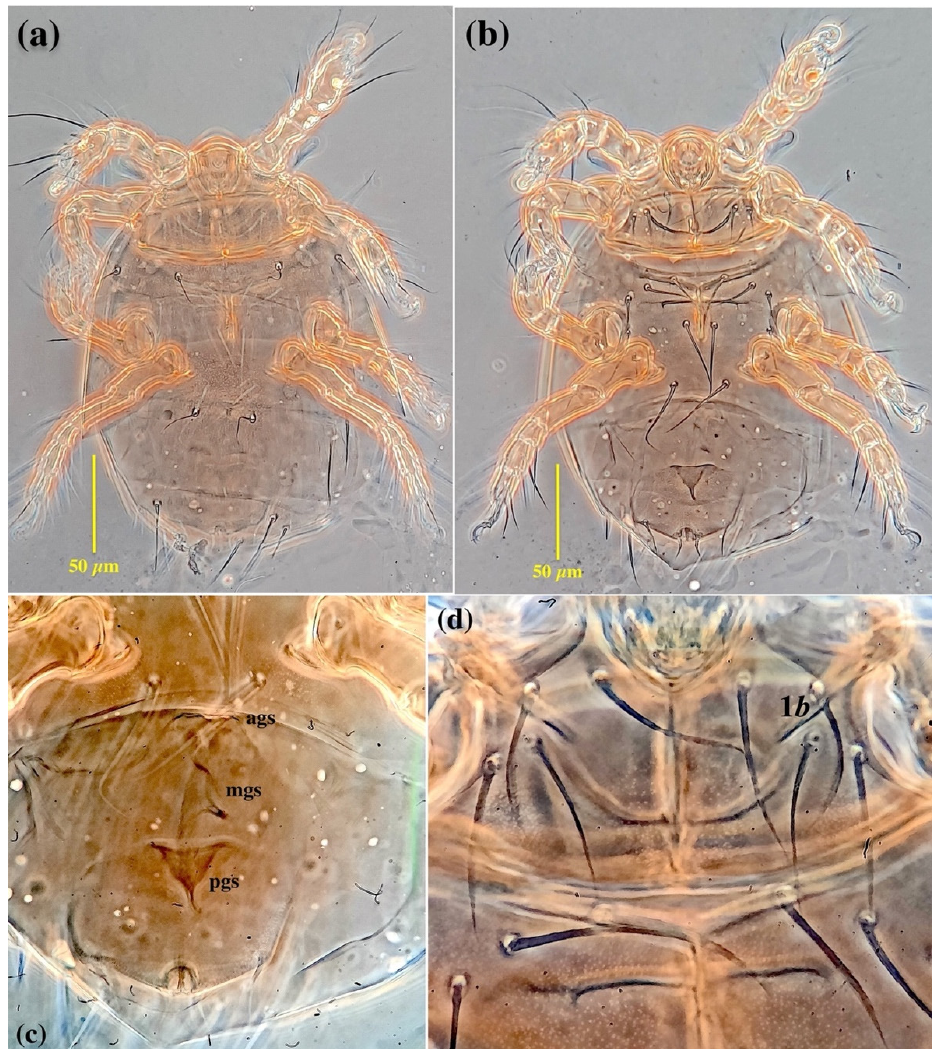
Figure 4. Micrograph of Allopygmephorus coelostomus sp. nov., phoretic female ( a ) general view dorsally; ( b ) general view ventrally; ( c ) genital sclerites; ( d ) setae 1 b with a notch or slit in the distal half. Idiosomal dorsum (Figures 2a and 4a): Anterior margin of tergite C covering posterior half of prodorsum; all dorsal plates ornamented with small dimples; stigmata subellipsoidal, associated with elongate atria with posterior tracheal branches; trichobothria clavate and smooth. All dorsal setae sharply pointed except seta e, which is distinctly stiff and blunt- ended. Setae sc 2, c 1, c 2, d and e smooth, setae f , h 1 and h 2 with a couple of barbs. Posterior margin of tergite H protruded. Cupules ia on tergite D moderately elliptical; plates EF and H without cupules im and ih , respectively. Length of dorsal setae: sc 2 17 (13–16), c 1 21 (22–25), c 2 20 (18–23), d 23 (24–26), e 17 (13–16), f 35 (35–40), h 1 33 (31–34), h 2 30 (30–32). Distances between dorsal setae: sc 2– sc 2 48 (47–50), c 1– c 1 49 (47–51), c 2– c 2 105 (103–115),